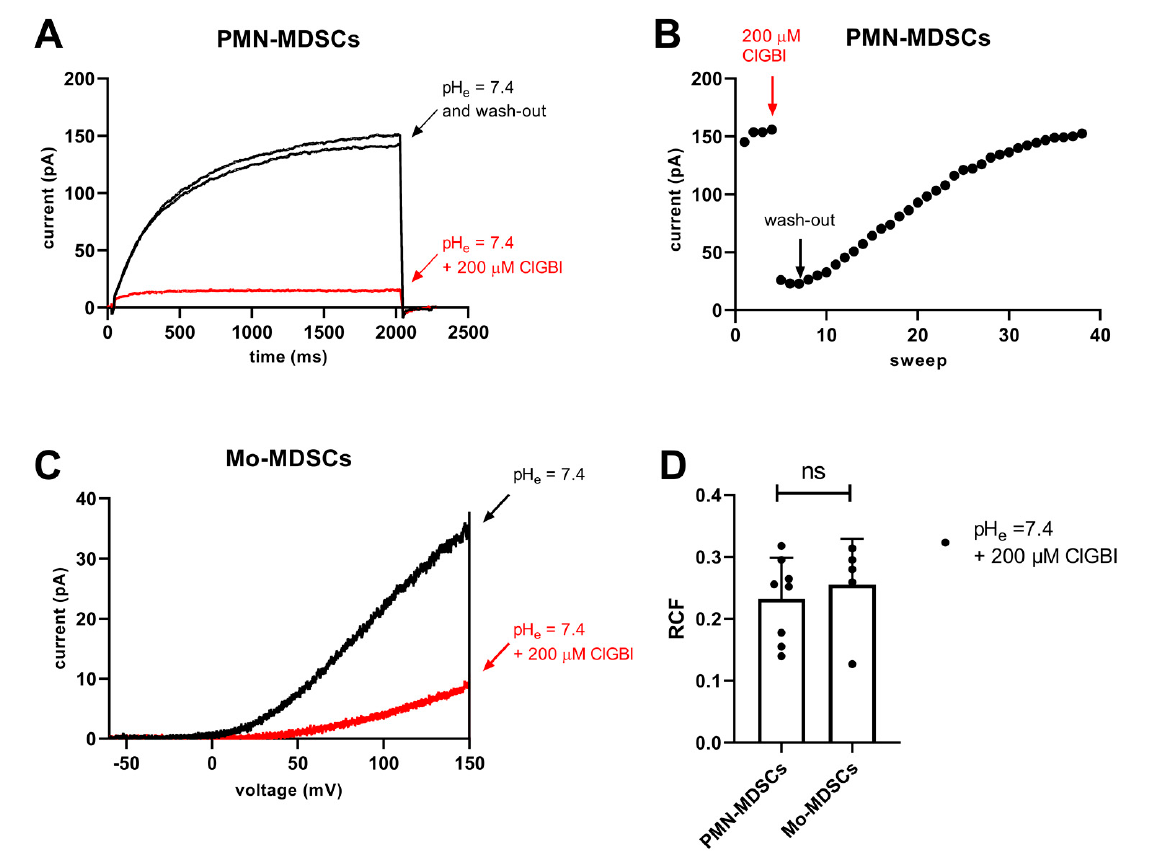
Figure 11. Inhibition of Hv1 currents in murine PMN- and Mo-MDSCs by ClGBI. ( A ) Representative whole-cell currents in a PMN-MDSs (holding potential: − 80 mV, depolarization to +100 mV, every 15 s) prior to the application of ClGBI (black), at equilibrium block by 200 µ M ClGBI (red) and following was-out (black). The pH i and the pH e were 6.2 and 7.4, respectively. ( B ) Representative time course of the onset and the recovery of the Hv1 current inhibition for the cell shown in panel A. Peak currents were determined as the average of the last 18 data points at +100 mV (see Materials and Methods); red and black arrows indicate the start of ClGBI application and the wash-out by ClGBI-free solution, respectively. ( C ) Representative whole-cell currents in a Mo-MDSCs (holding potential: − 80 mV, voltage-ramp from − 60 mV to +150 mV, every 10 s) prior to the application of ClGBI (black) and at equilibrium block by 200 µ M ClGBI (red). Representative of 8 ( A , B ) and 5 ( C ) similar cells. Every trace has been filtered with a 25-point boxcar filter. ( D ) Remaining current fractions (RCF) in the presence of 200 µ M ClGBI. Peak currents were determined for voltage-steps (PMN-MDSCs) and voltage-ramps (Mo-MDSCs) as described in the Materials and Methods. RCF was calculated as I/I 0 where I 0 and I are the peak currents in the absence and in the presence of 200 µ M ClGBI upon reaching equilibrium block, respectively. Bars and error bars indicate the mean ± SEM, data points are determinations of RCF values in individual cells (PMN-MDSCs, n = 8; Mo-MDSCs, n = 5). Data were compared using Student’s t -test with Welch’s correction ( p = 0.591, ns = not significant).